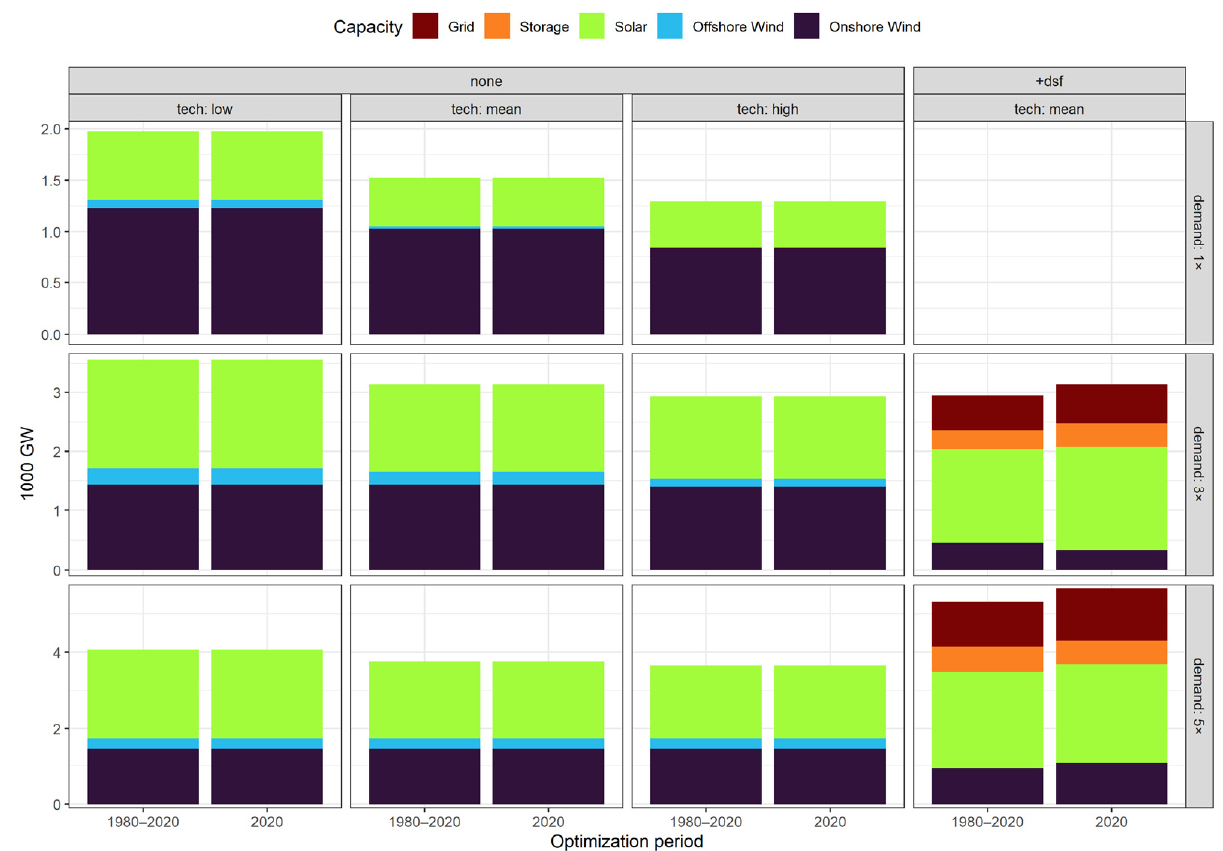
Figure 16. Comparison of capacity structure optimised based on 41 years of weather data (1980–2020) and 1 year of weather data (2020) by scenario.